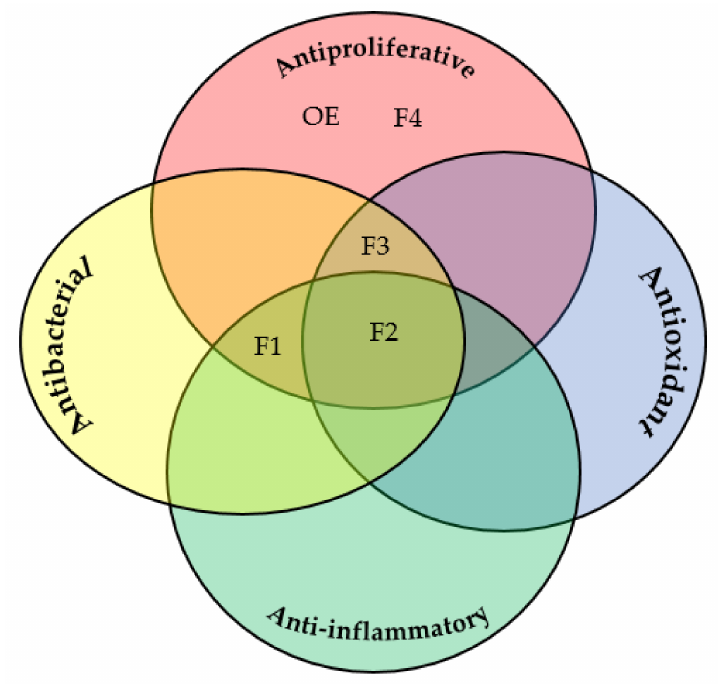
Figure 1. Observed biological activities for OE and F1 – F4 obtained from E.